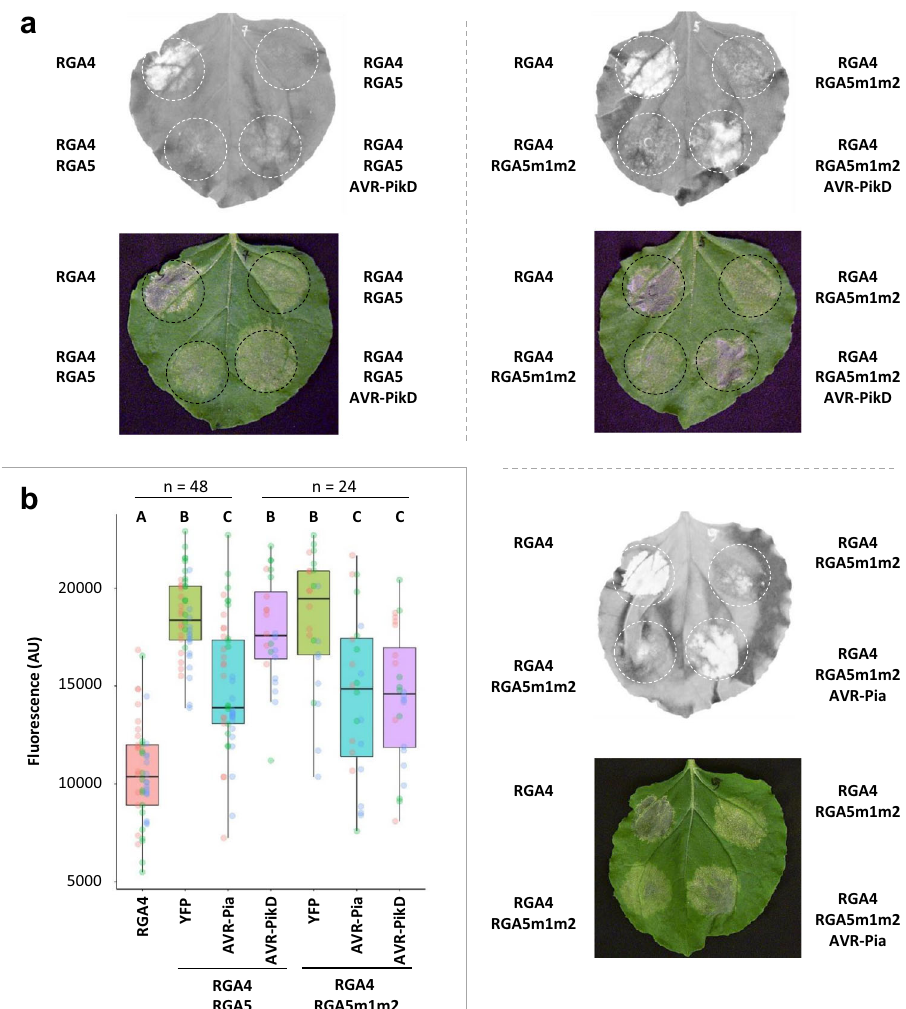
Fig. 7 The RGA5m1m2 mutant recognizes AVR-Pia and AVR-PikD in N. benthamiana . a The indicated combinations of constructs were transiently expressed in N . benthamiana leaves. The AVR-PikD (without signal peptide) and RGA4 constructs carry an HA tag at their C-termini, while RGA5 and RGA5m1m2 are YFP-tagged at their N-termini and AVR-Pia (without signal peptide) is untagged. The auto-active RGA4 construct was used as a positive control for cell death induction. Cell death was visualized 5 days after in fi ltration. Greyscale pictures were taken using a fl uorescence scanner with settings allowing visualization of the disappearance of red fl uorescence due to cell death (white patches of dead cells). A picture of corresponding leaves is shown below. b Cell death was quanti fi ed by measuring fl uorescence levels (arbitrary unit, AU) in the in fi ltrated areas using ImageJ 34 . The resulting data were plotted. The boxes represent the fi rst quartile, median, and third quartile. The difference in fl uorescence levels was assessed by an ANOVA followed by a Tukey HSD test. Groups with the same letter ( a – c ) are not signi fi cantly different at level 0.05. For each combination of constructs, all of the measurements are represented as dots with a distinct color (red, green, and blue) for each of the three biological